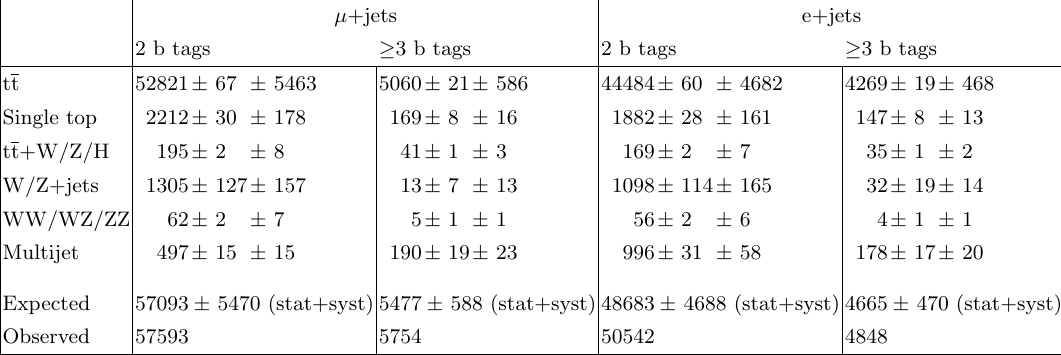
Table 1 . Observed event yields and estimated backgrounds for the (cid:22) +jets and e+jets channels satisfying the event selection criteria. The number of b-tagged jets is the number of b tags among the four jets with highest p T in the event. The (cid:12)rst and second uncertainty shown corresponds to the statistical and systematic components,